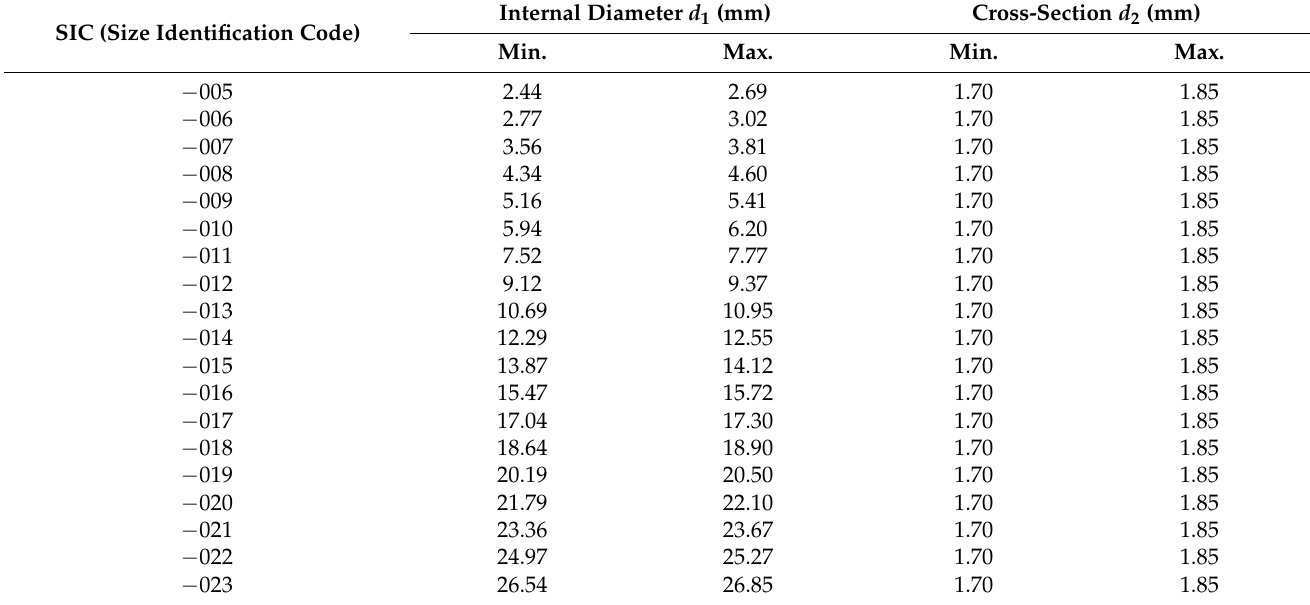
Table 3. Inside diameters, cross-sections, and tolerances for O-rings.